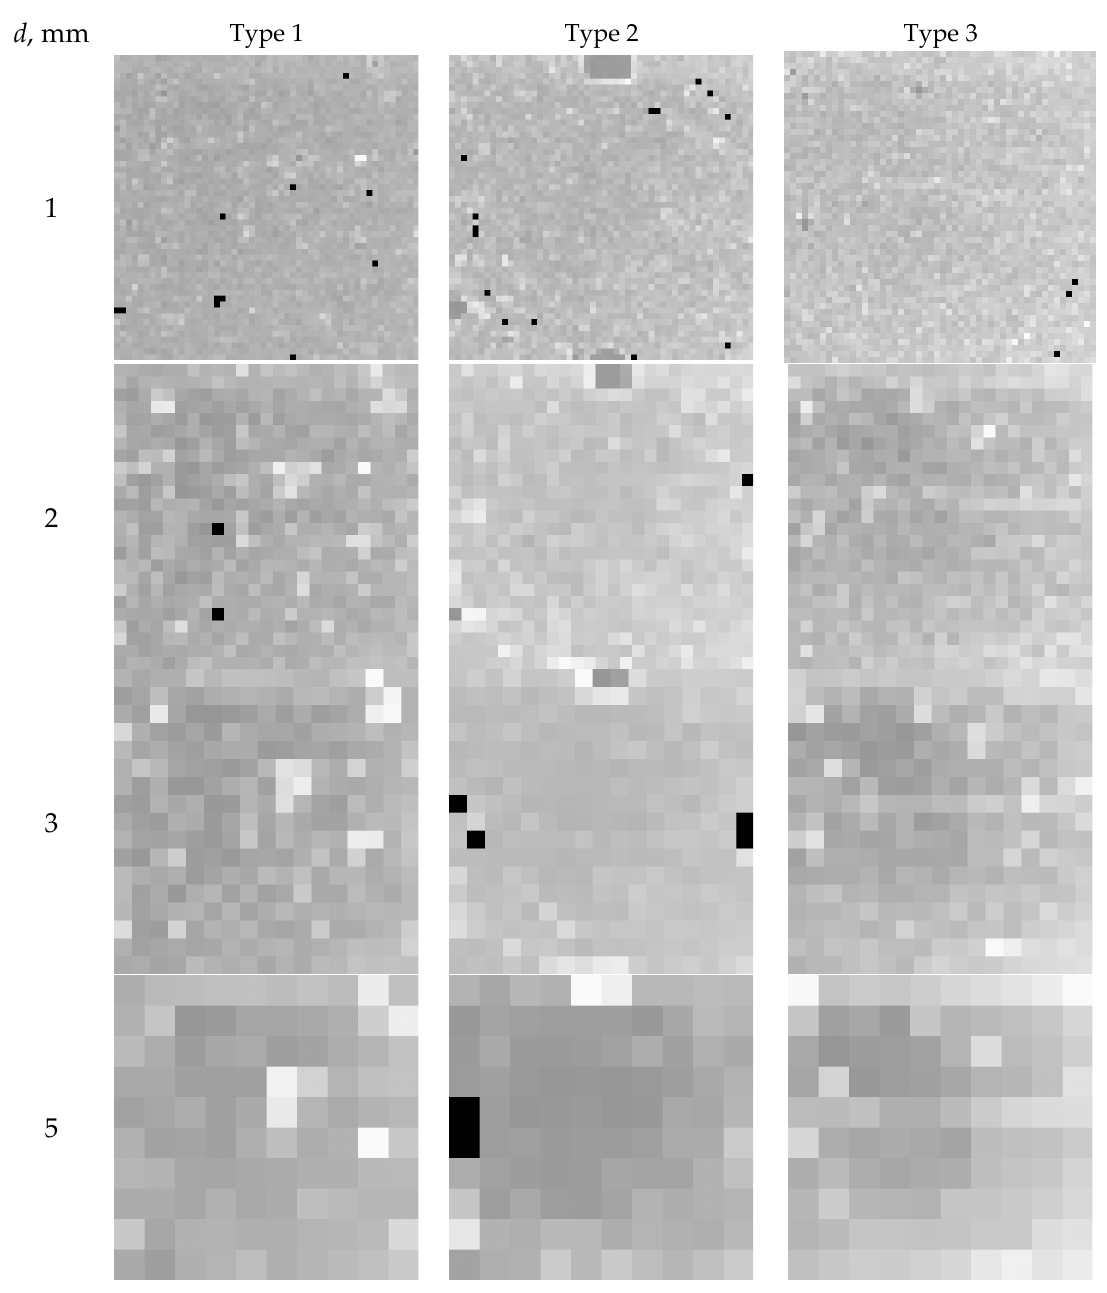
Figure 7. Homogeneity of pore distribution by STD ση in local volumes with size d , mm.